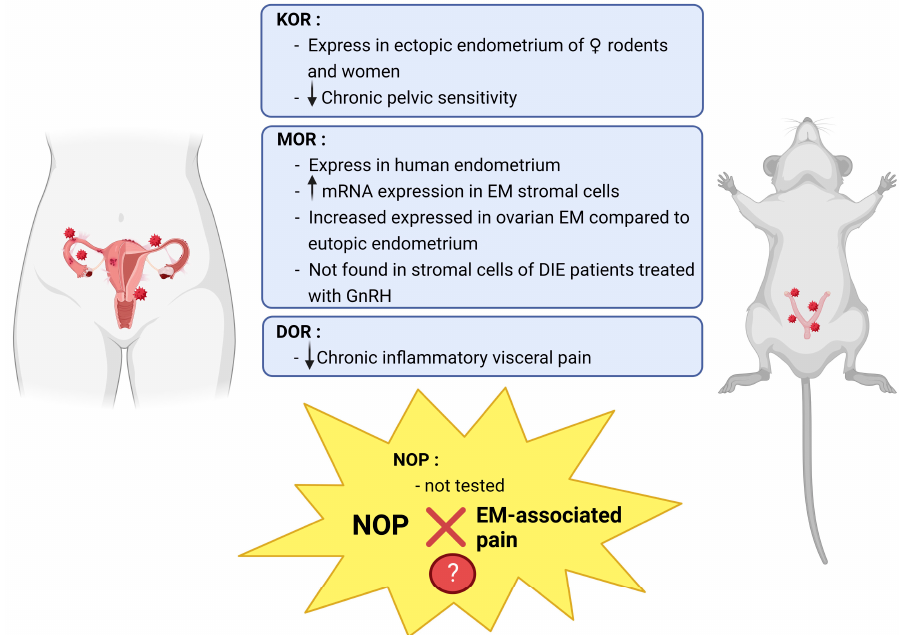
Figure 2. Opioid receptors and EM-associated pain. The endogenous opioid system is involved in modulating neurogenic inflammation, while endometriosis is a chronic inflammatory disease. In the studies regarding opioid receptor expression in the endometrium, both MOR and KOR are more or less related to EM-associated pain. Although to date, no evidence has shown that DOR antagonists can alleviate EM-associated pain, DOR agonists were reported to be active in the periphery and probably alleviate the chronic inflammatory visceral pain. Regarding NOP, what we know is its wide expression both in the central and peripheral nervous systems. Meanwhile, NOP receptors also have a high distribution within the immune system. To date, the relationship between EM-associated pain and NOP or N/OFQ remains unknown. KOR: kappa opioid receptors; MOR: mu-opioid receptors; DOR: delta opioid receptors; NOP: nociceptin/orphanin FQ peptide receptor; EM: endometriosis; GnRH: gonadotropin-releasing-hormone; DIE: deep infiltrating endometriosis.